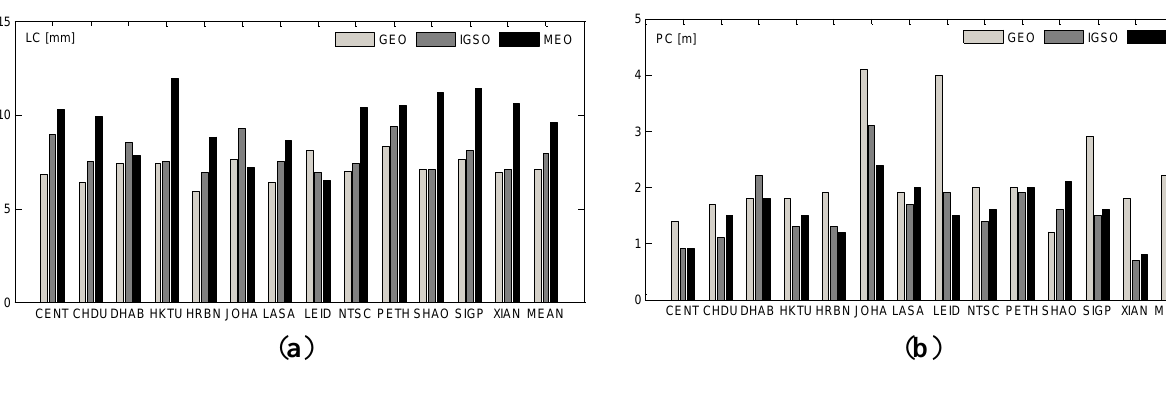
Figure 6. ( a ) The averaged RMS of LC observation residuals for each station-satellite pair. ( b ) The averaged RMS of PC observation residuals for each station-satellite